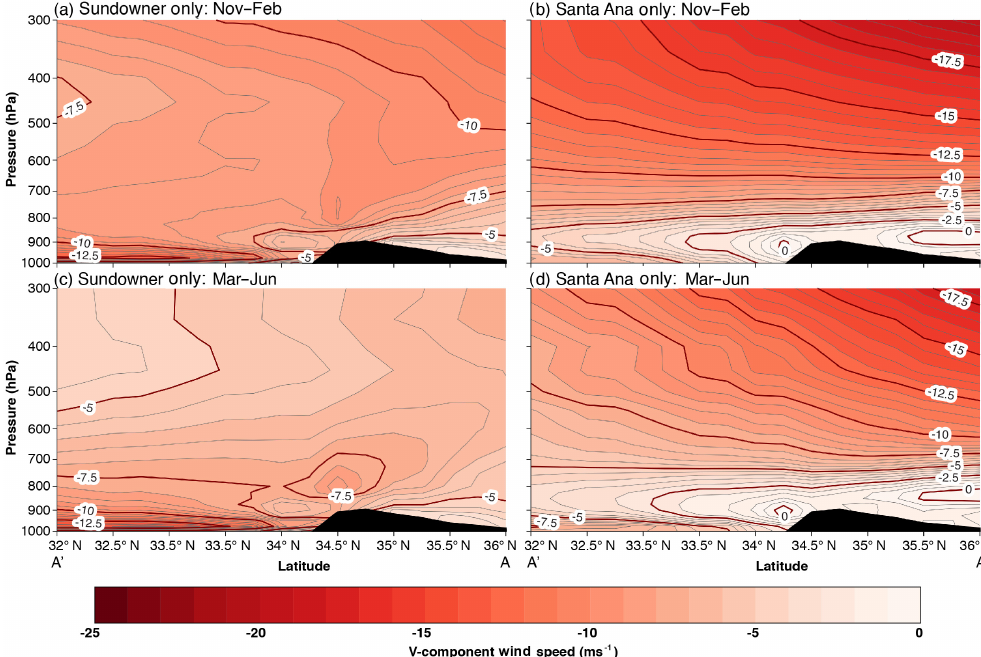
Figure 5. (a-d) Composite North American Regional Reanalysis northerly ( v -component) winds (filled contours; thin contour interval 0.5ms − 1 thick contour interval 2.5ms − 1 ) for the cross section spanning 32–36 ◦ N through the center of the study area at a longitude of 120 ◦ W. Black areas denote NARR